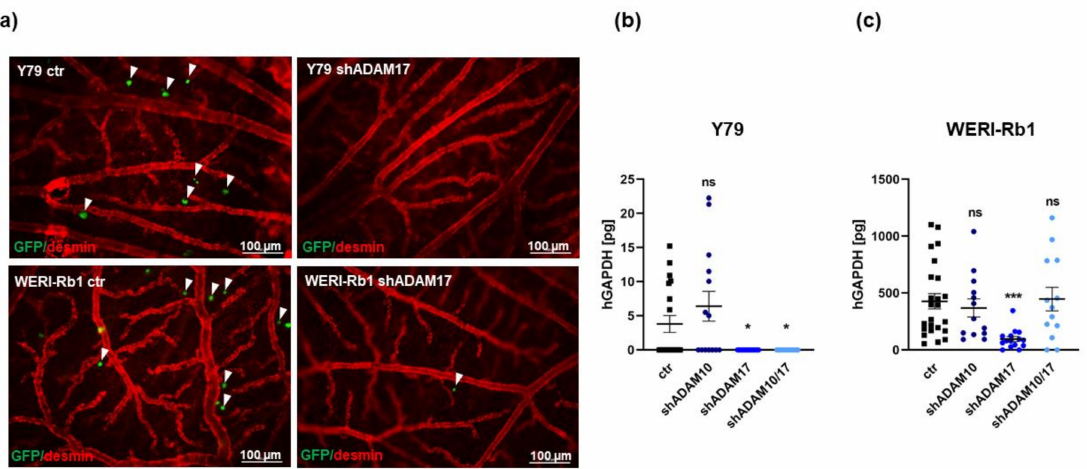
Figure 7. Effects of stable, lentiviral ADAM10/17 single or double knockdown on RB cell migration in vivo. ( a ) Desmin stains of blood vessels (red) in representative CAM whole mounts